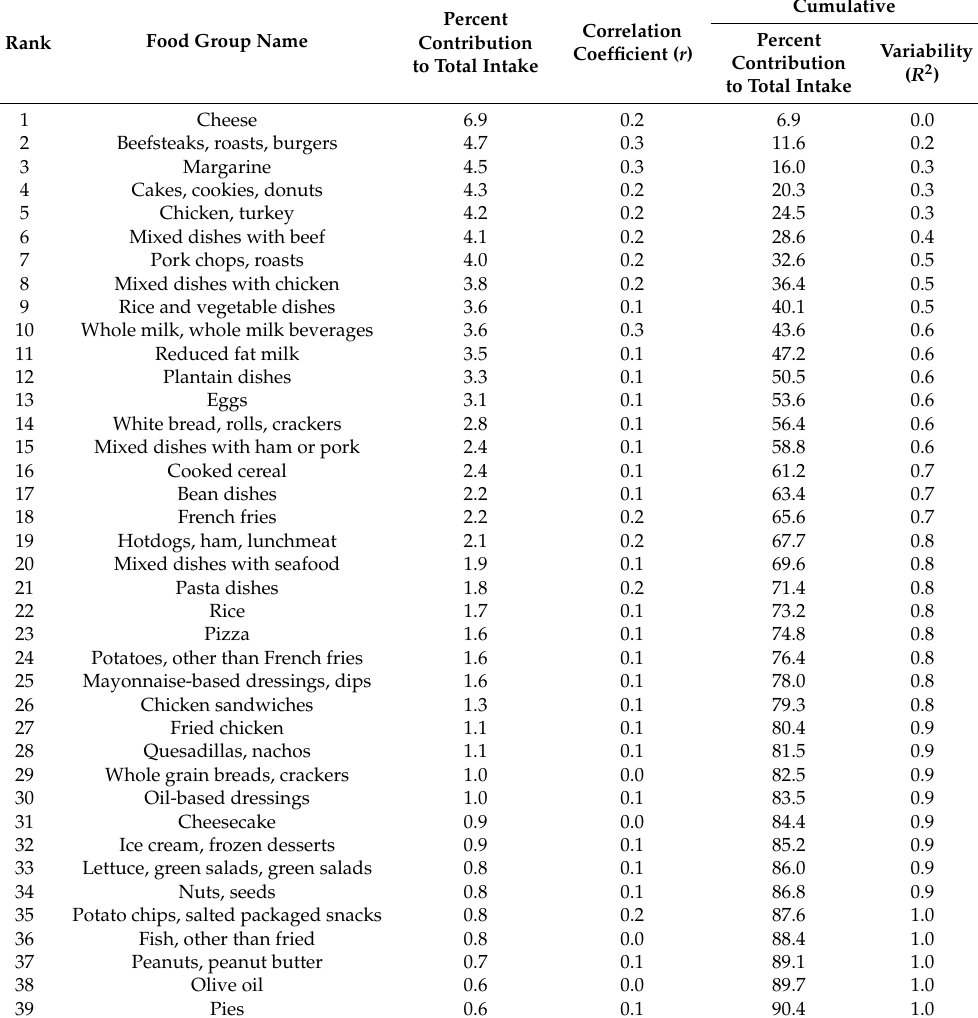
Table 2. Foods contributing to fat (g) intake, Puerto Rican women.